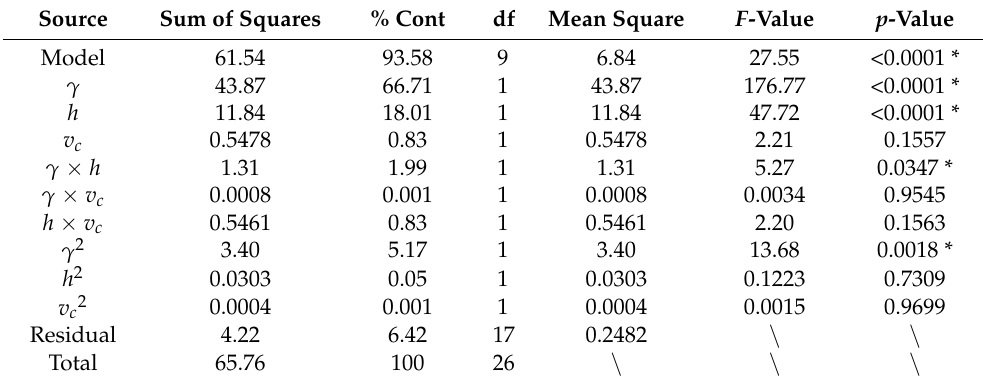
Note: * indicates p < 0.05.